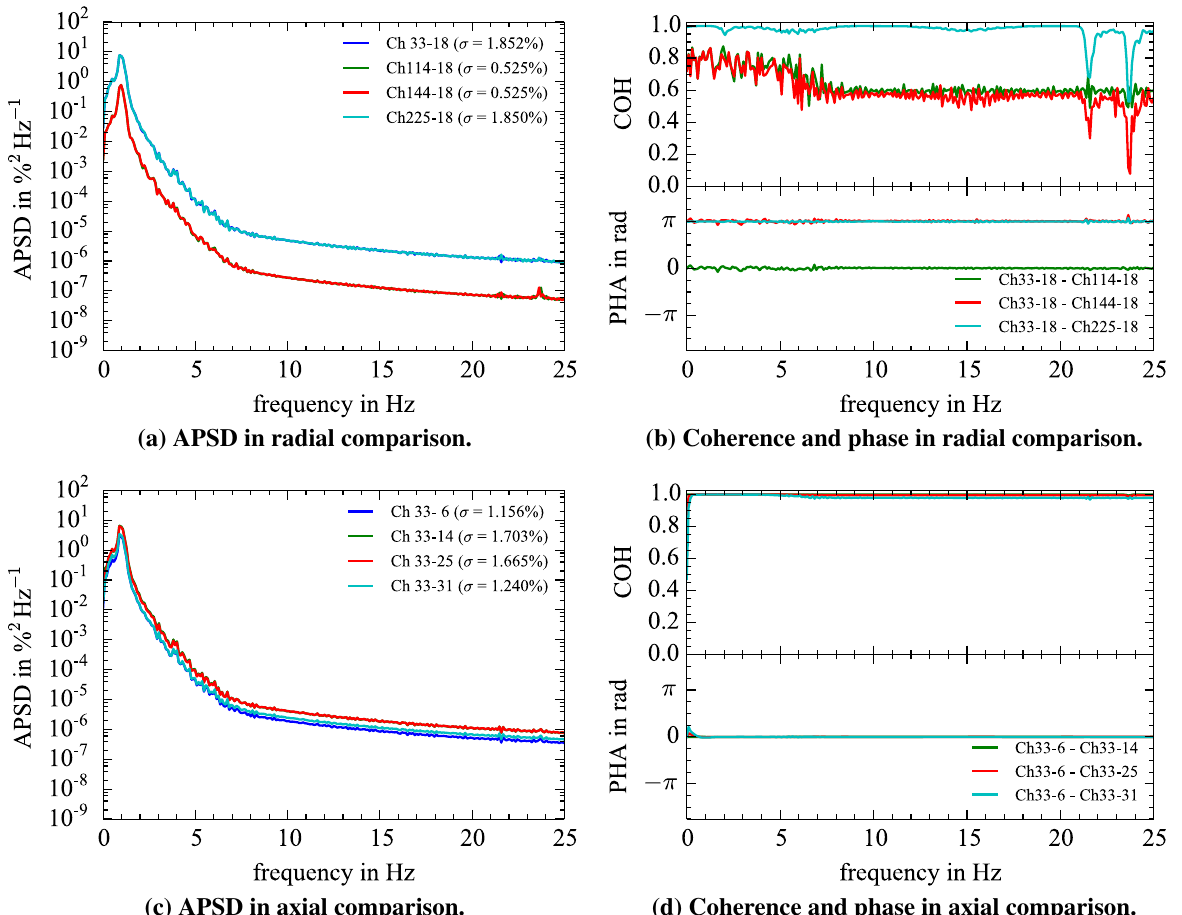
Figure 3: Nodal power-density fluctuations simulated with DYN3D assuming a synchronized fuel-assembly vibration under fixation of the outermost fuel-assembly